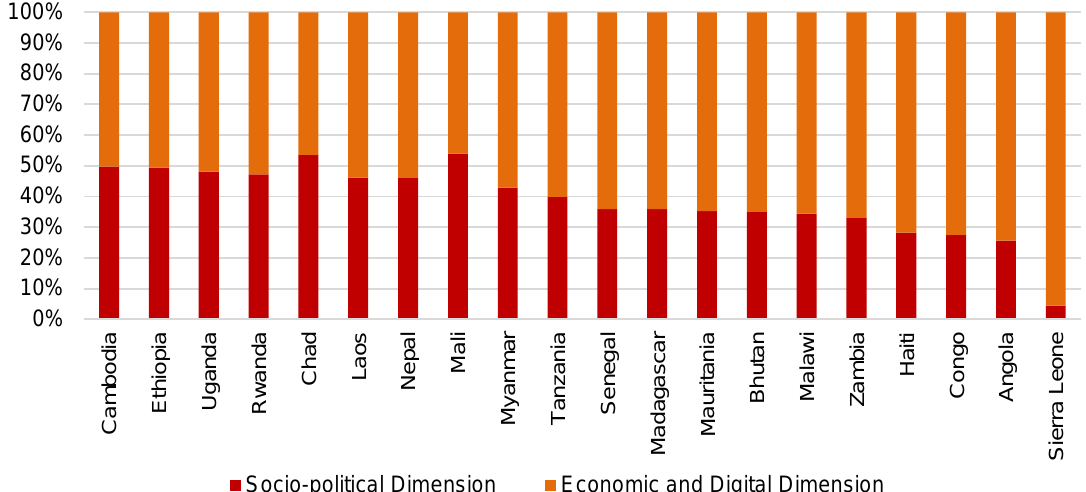
Figure 9. Balancing composite targets of economic, social, political and digital capability and cybersecurity dimensions for the least developed countries. Source: Authors’ calculations